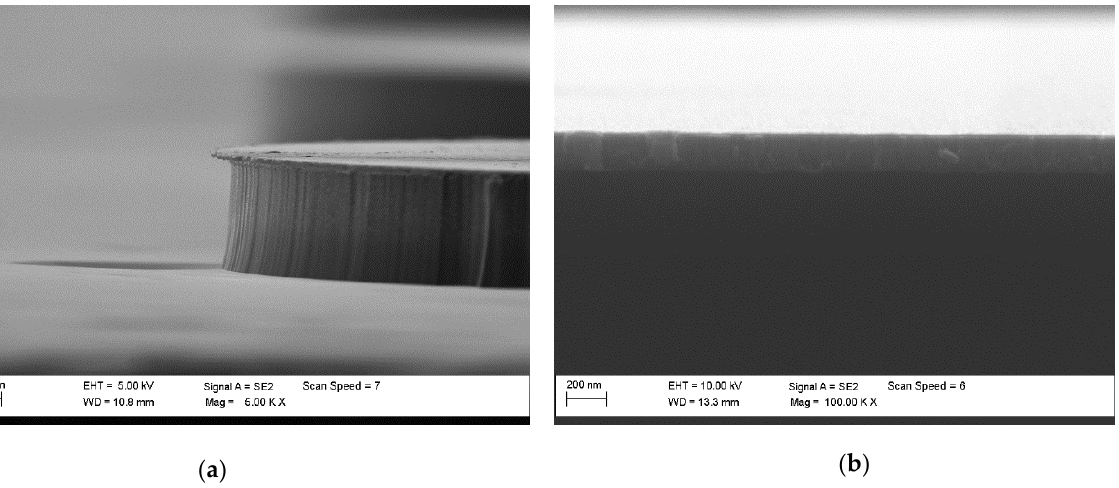
Figure 18. ( a ) The SEM photo of the SiC/Cr MESA structure with ( b ) ~210 nm layer of chromium at the top (the result of 119 min etching).